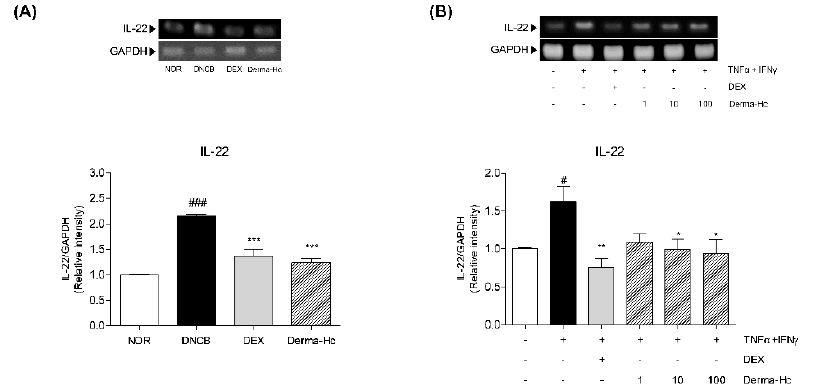
Figure 9. Derma-Hc down-regulates the expression level of IL-22 in ( A ) DNCB-induced mice and ( B ) TNF- α +IFN- γ -treated human keratinocytes. The mRNA level of IL-22 was measured by RT-PCR. Three repeats of an experiment were conducted. The data are presented as mean ± standard error of the mean. # p < 0.05 and ### p < 0.001 compared to NOR group. * p < 0.05, ** p < 0.01 and *** p < 0.001 compared to individual groups.